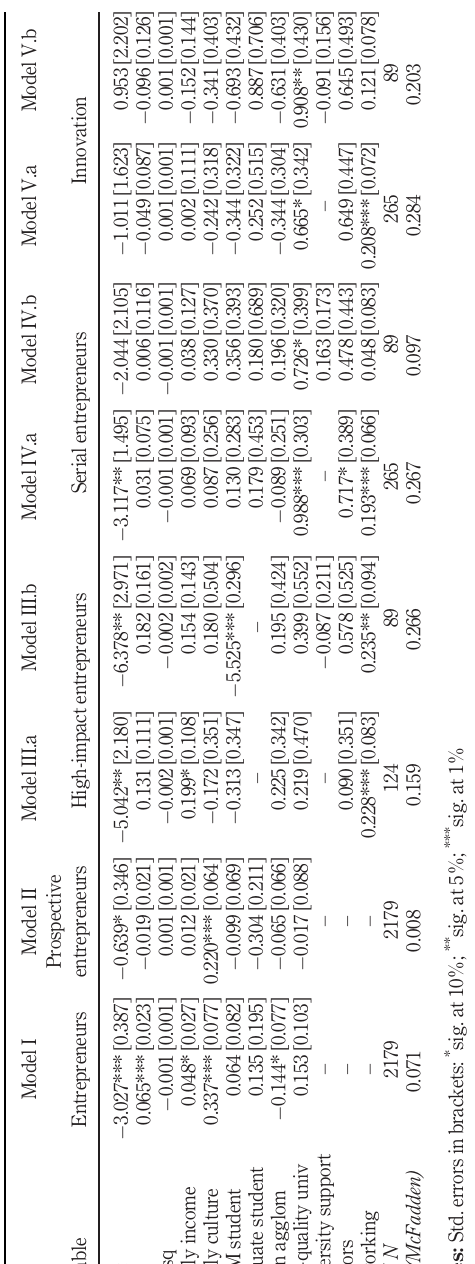
Table III. Probit